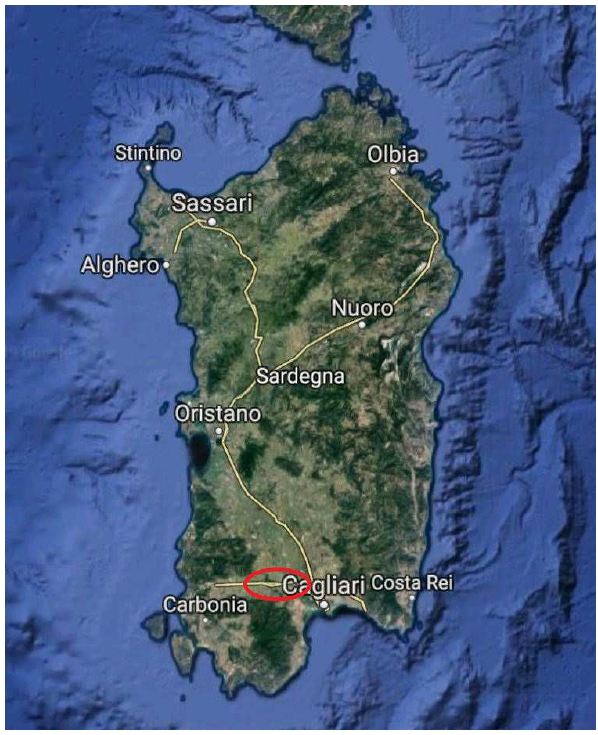
Fig. 1. Satellite framing of the case study.